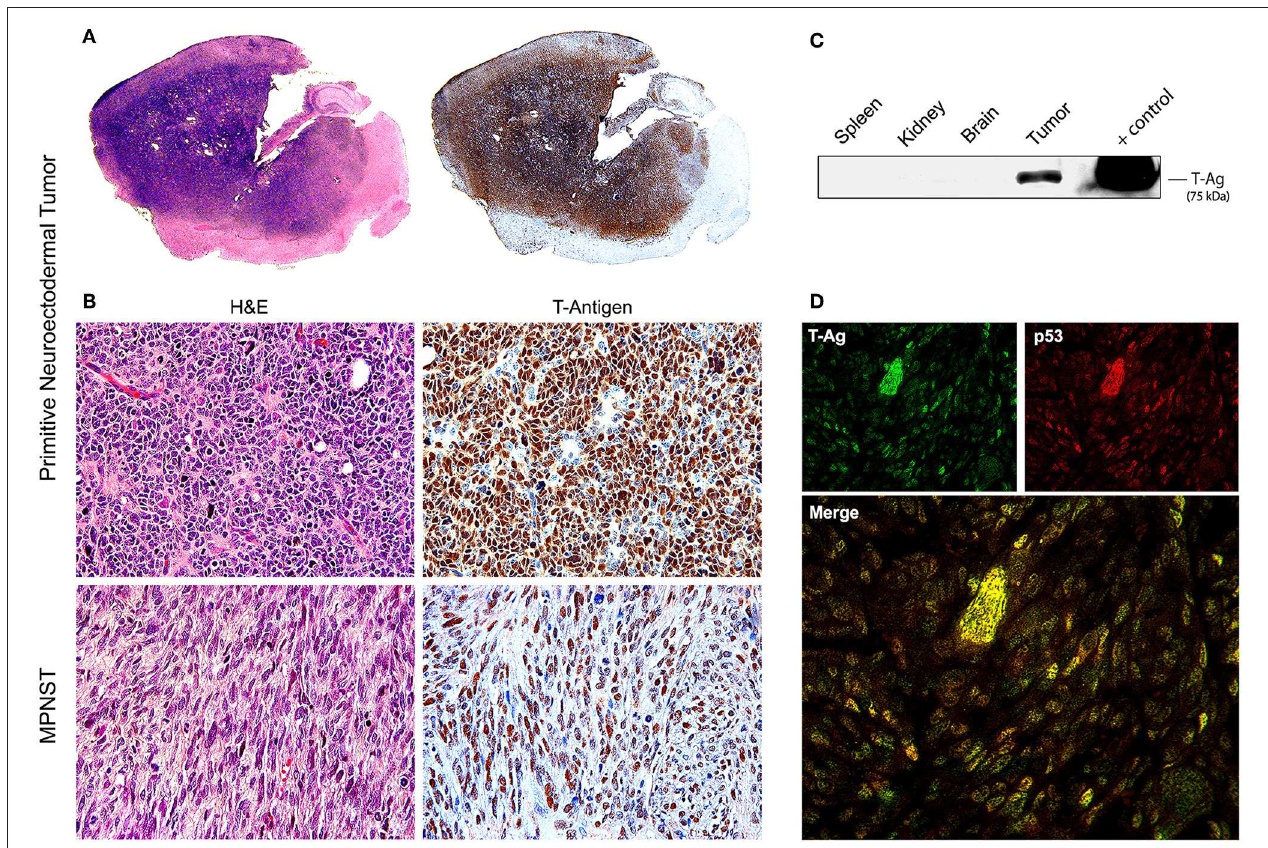
FIGURE 3 | Tumors in transgenic mice. (A) Consecutive montages of the brain of a JCPyV transgenic mouse demonstrating a large blue, small-cell tumor, that practically substitutes the entire parenchyma. By immunohistochemistry, the entire tumor expresses T-Antigen, indicating the activity of the T-Antigen transgene. (B) At higher magnification, the tumor is composed of sheets of poorly differentiated cells with a marked lack of cytoplasm, indicating their embryonal phenotype. Immunohistochemistry for T-Antigen shows nuclear expression in the majority of neoplastic cells (Original magnification 400x). Histological pictures of a malignant peripheral nerve sheath tumor (MPNST) and its expression of T-Antigen are also shown. (C) A Western blot of different tissues of the mouse shows the expression of T-Antigen exclusively in the tumors. Although all cells from all tissue carry the transgene. (D) Double labeling immunofluorescence in a PNET shows co-localization of T-Antigen and wild-type p53 in the nuclei of neoplastic cells. Both proteins are expressed at different degrees in the tumor cells (Original magnification